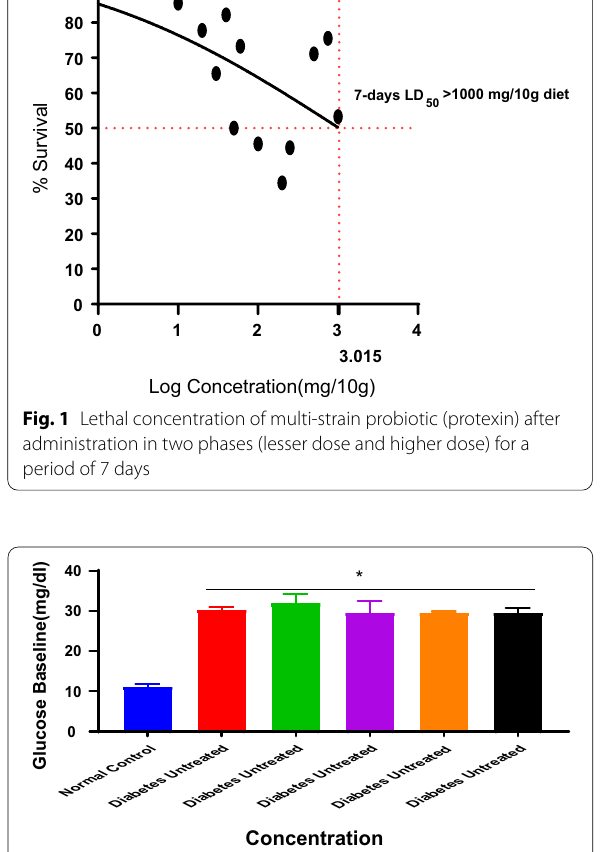
Fig. 2 Glucose baseline (diabetes induction) in sucrose induced D. melanogaster . Error bars with superscripts. *Indicate statistically significant p < (0.05)